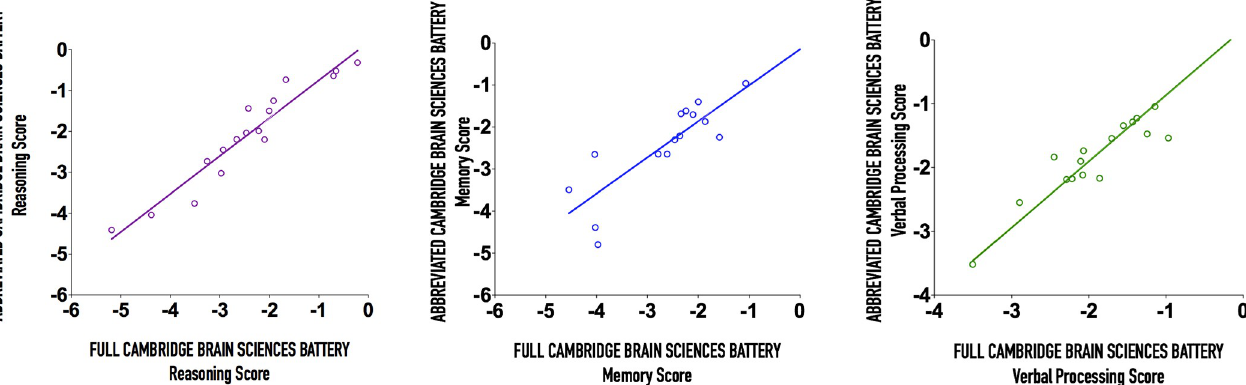
Fig 4. Scatterplots including a linear fit of the abbreviated Cambridge Brain Sciences Battery against the full battery on the three CBS cognitive domains. (A) Reasoning (r = 0.91), (B) Memory (r = 0.80), and (C) Verbal Processing (r = 0.94). Solid black line indicates x = y.